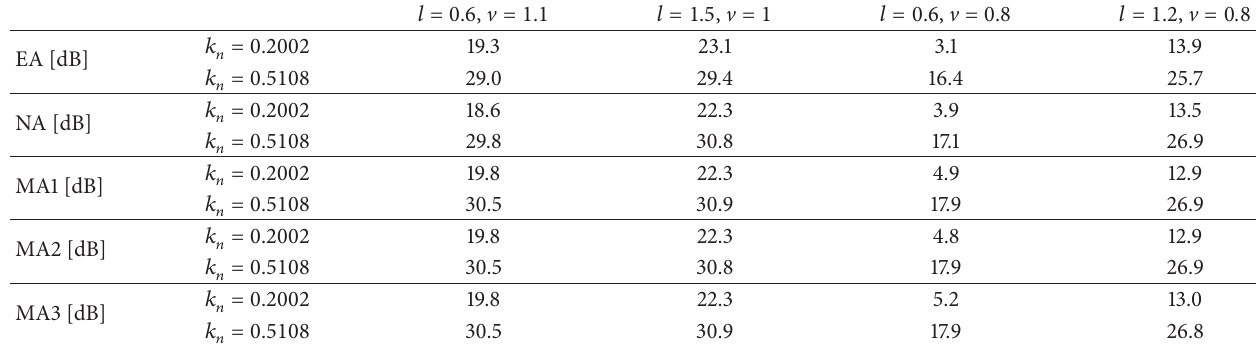
Table 8: Attenuations for the mode of the